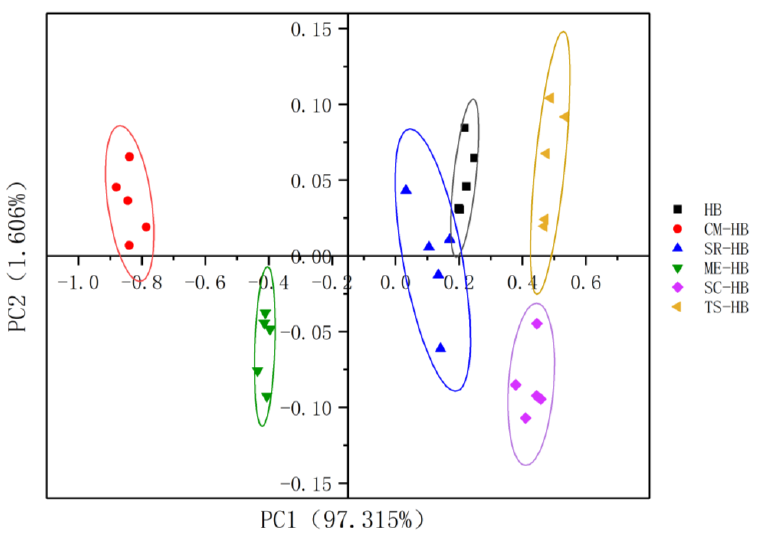
Figure 2. PCA of E-nose analysis for original and fermented highland barley samples: HB (original highland barley), CM-HB (fermented highland barley with C. militaris ), SR-HB (fermented highland barley with S. rugoso-annulata ), ME-HB (fermented highland barley with M. esculenta ), SC-HB (fer- mented highland barley with S. commune ), TS-HB (fermented highland barley with T. sanguinea ).